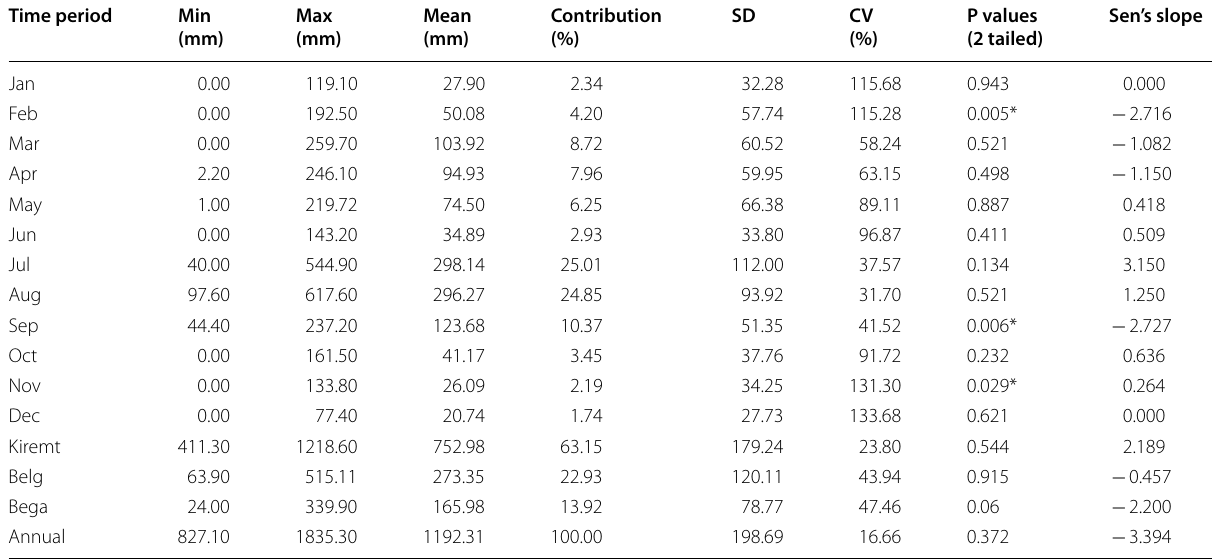
Table 3 Variability and trend tests of precipitation